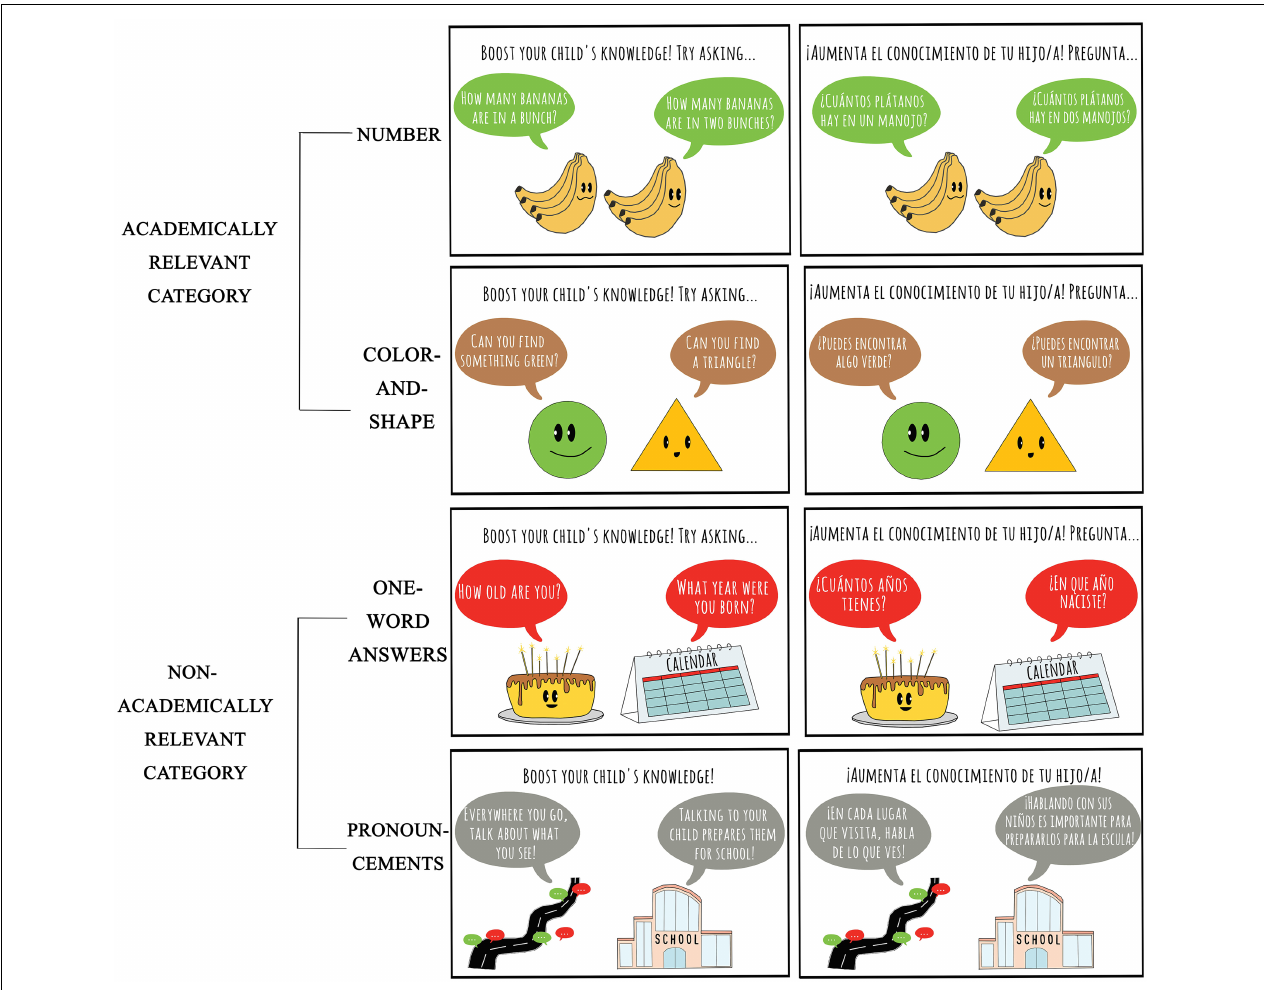
FIGURE 1 | Samples of the academically-relevant (top two rows) and non-academically-relevant (bottom two rows) signs. The remaining two sets of signs used in the study can be found in the Supplementary Material